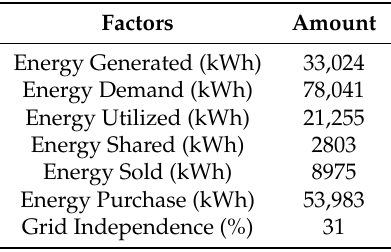
Table 7. Annual energy profile of the